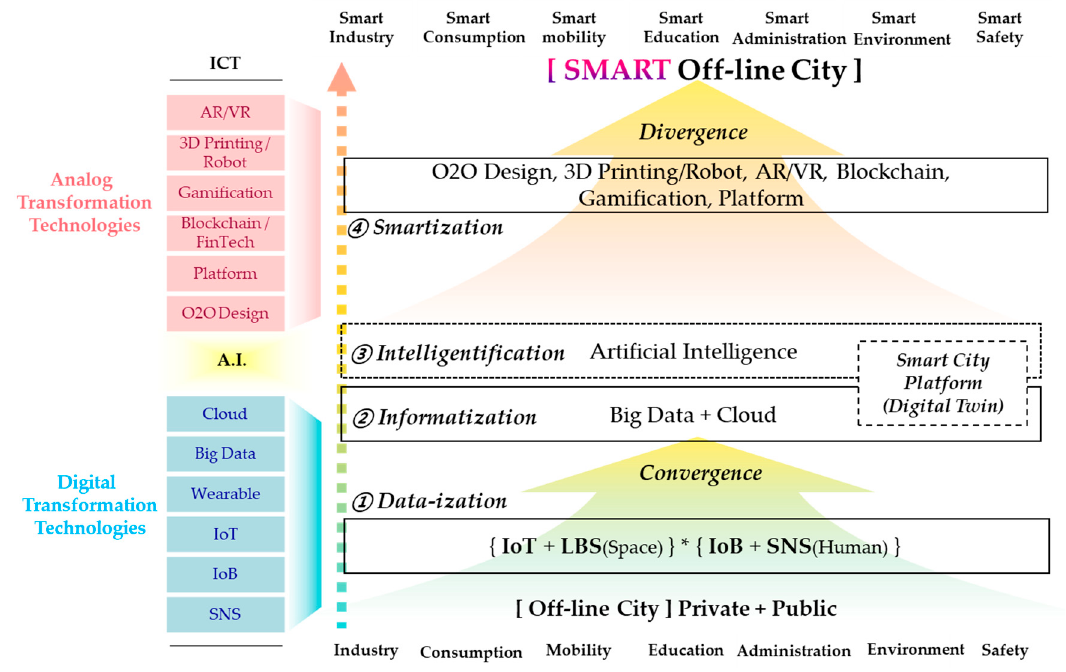
Figure 5. The 4-stage Model of Smart Transformation.